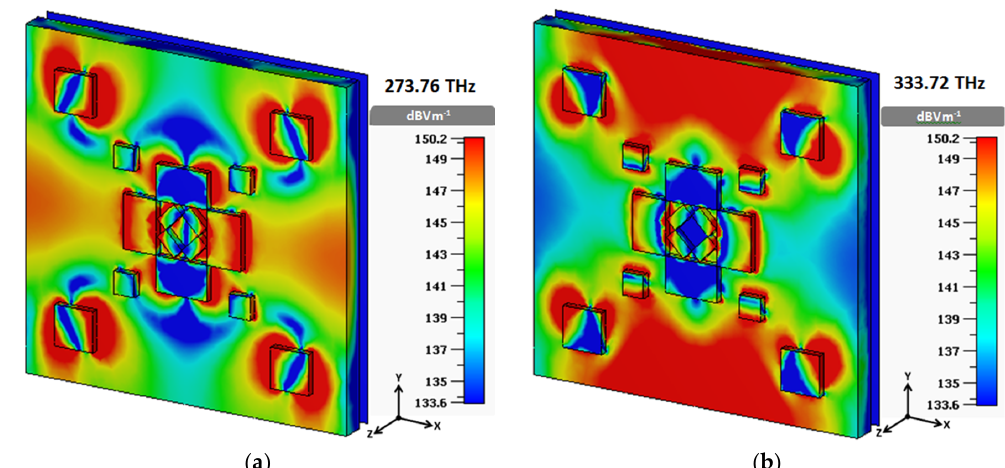
Figure 11. E-field distribution at ( a ) 273.76 THz and ( b ) 333.72 THz.